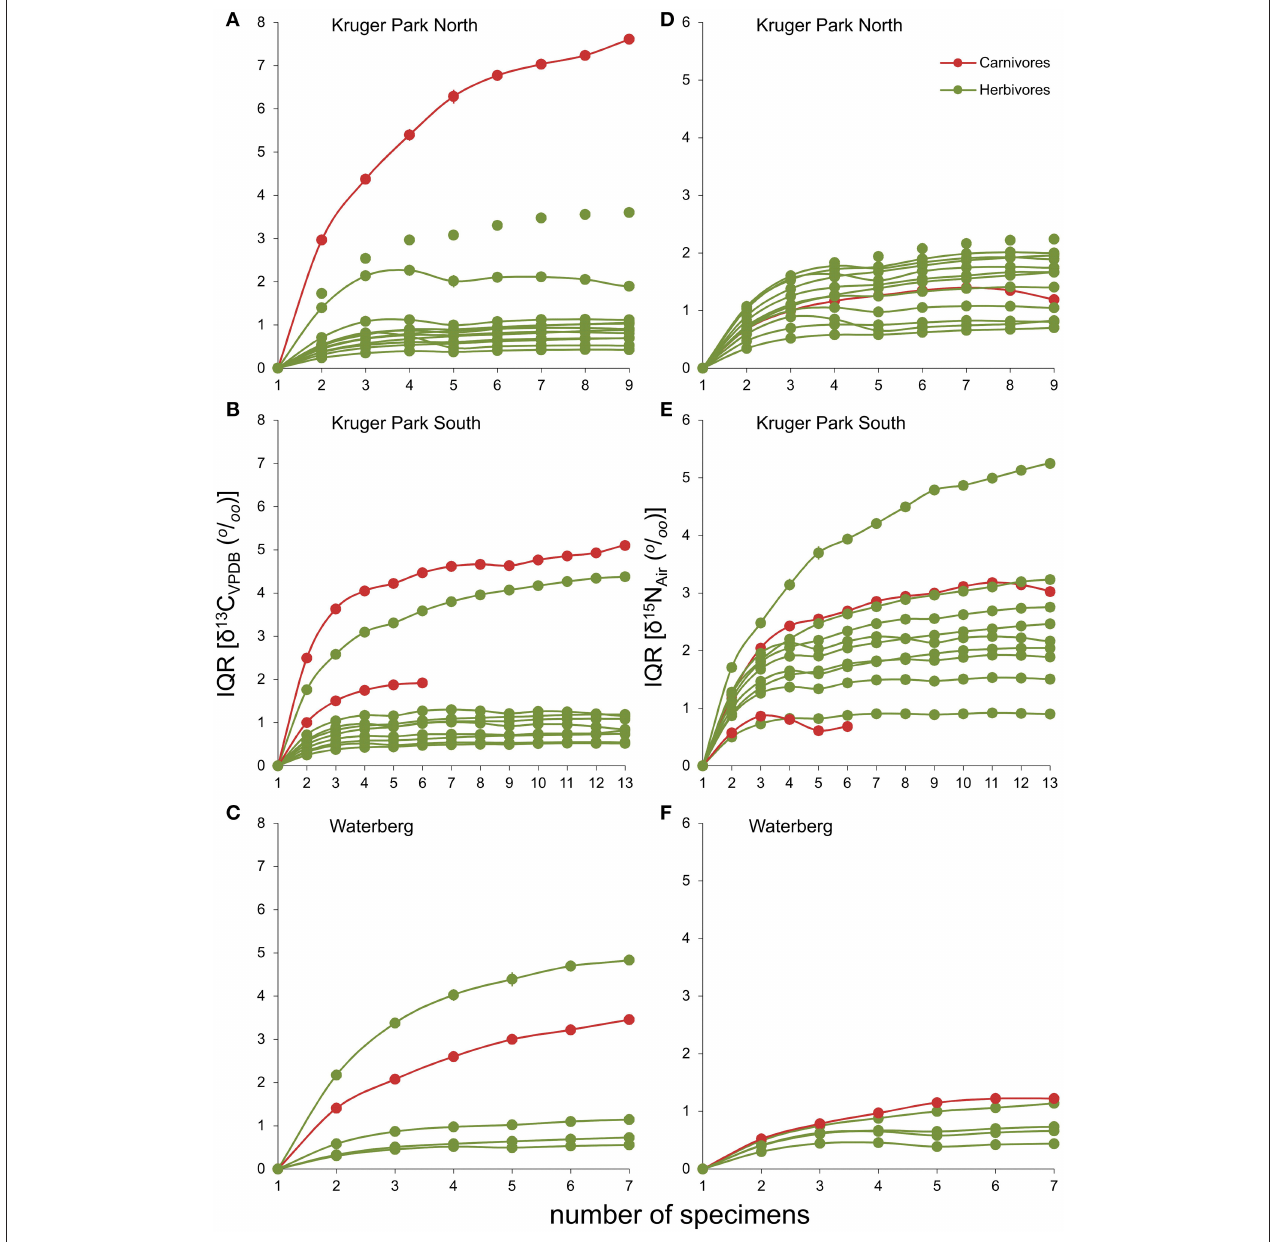
FIGURE 4 | Interquartile ranges for stable carbon (A–C) and nitrogen (D–F) isotopes of carnivores and herbivores for the three study sites, plotted as a function of sample size. Symbols depict means over 10 4 randomized permutations. Ninety-nine percent confidence limits are plotted as whiskers around the means, but are too small to be visible. Random subsamples were held at and below the maximum sample size for carnivores within each assemblage.